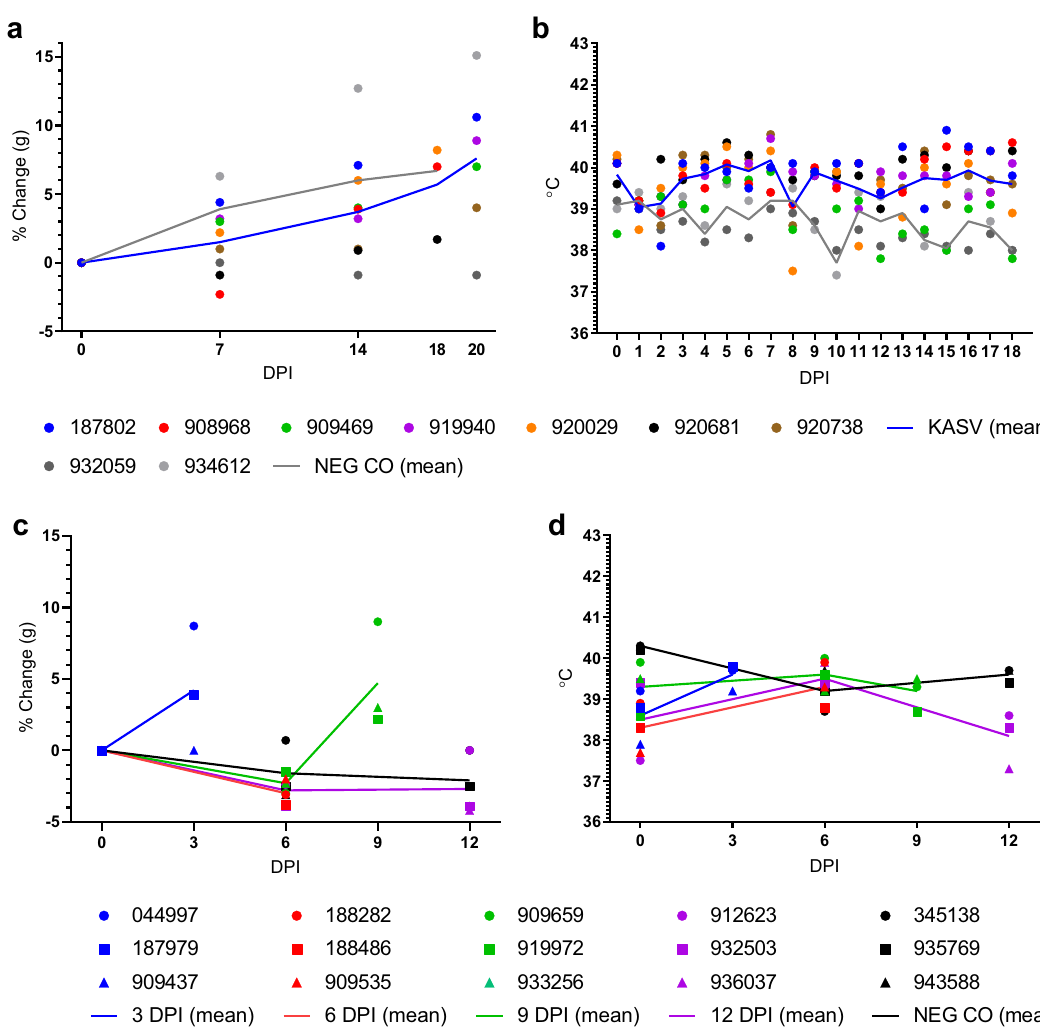
Figure 1. Weight and body temperature monitoring. ( a ) Percent weight change from baseline and ( b ) body temperatures of serially-sampled, Kasokero virus (KASV)-inoculated and negative control (NEG CO) bats, and ( c ) percent weight change from baseline and ( d ) temperatures of serially-euthanized, KASV-inoculated and NEG CO